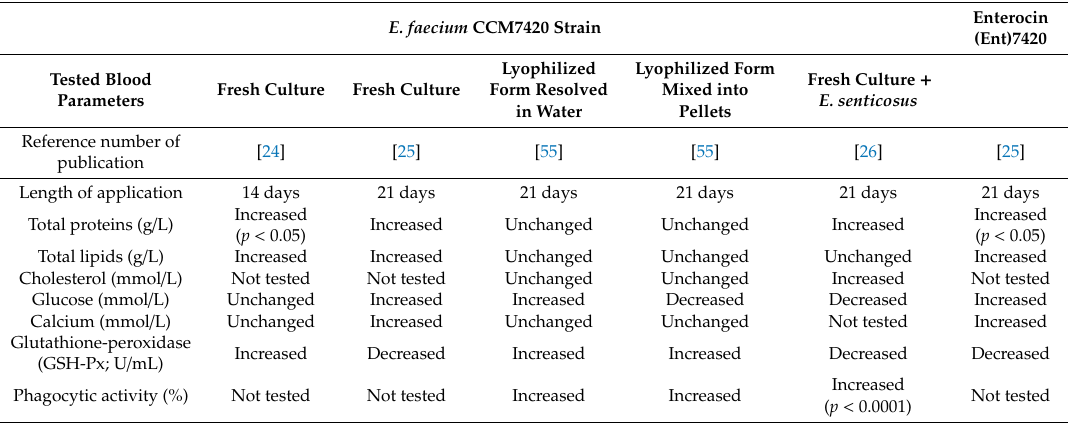
Table 3. The e ff ect of Enterococcus faecium CCM7420 and its enterocin Ent7420 on the serum biochemistry of